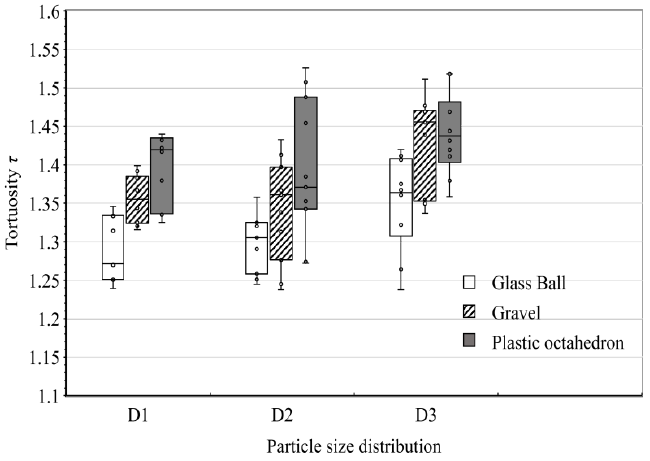
Figure 20. Box plot of the tortuosity of the traces in the flow field from the simulation.